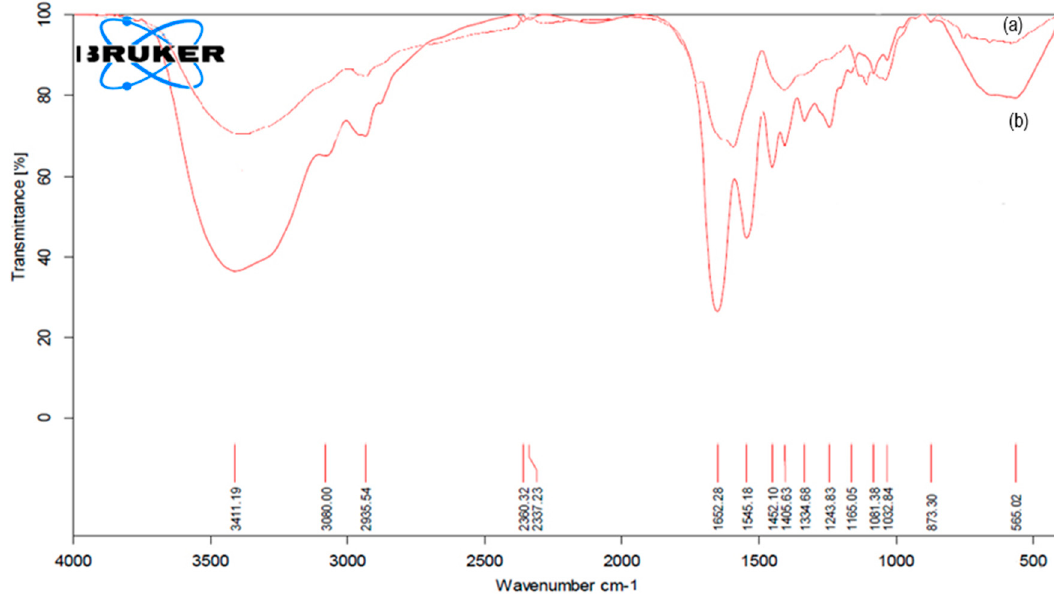
Figure 8. FTIR spectra of gelatin-AuNPs (curve a ) and gelatin (curve b ). Table 4. FTIR bands position of pure gelatin and gelatin-AuNPs presented in Figure